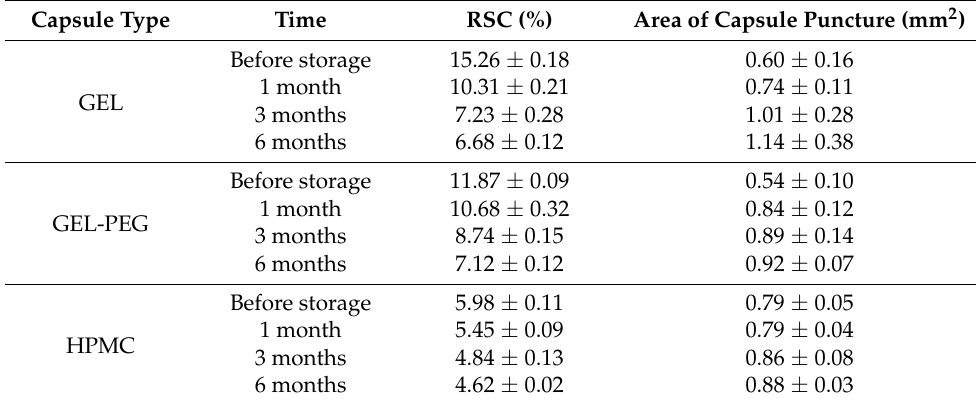
Table 3. RSC of capsule walls and areas of holes formed during punching.